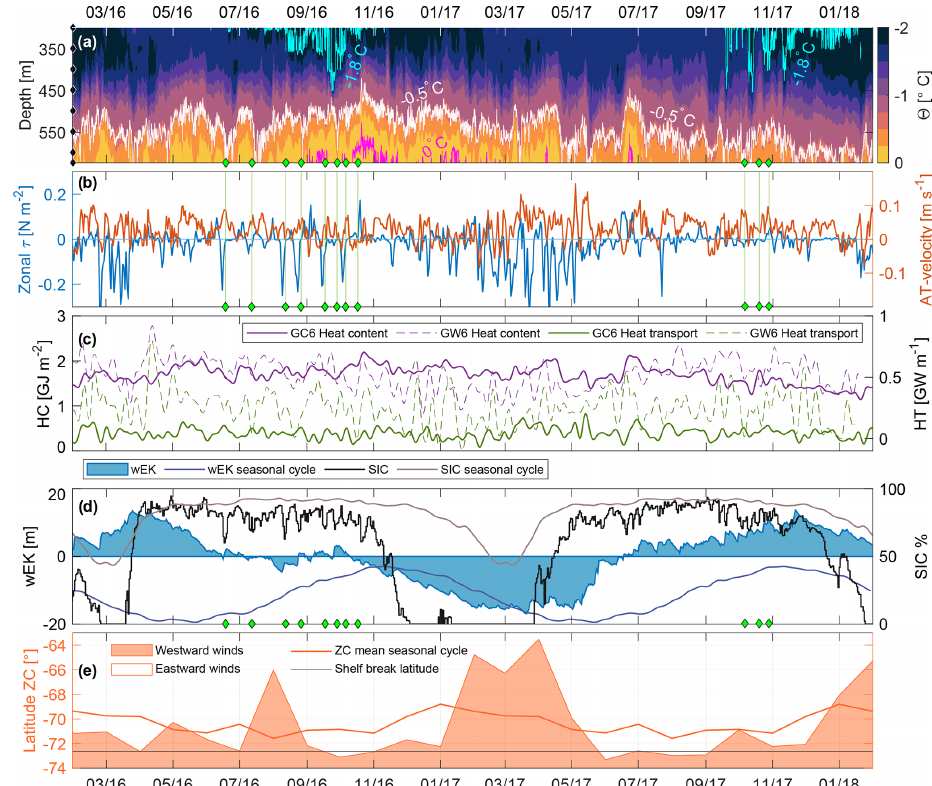
Figure 4. Daily mean records from GC 6 showing (a) conservative temperature, and (b) depth-averaged along-trough (AT) velocity at GC 6 (red) and zonal τ D18 averaged over the SB box (blue). Positive values denote flow toward the ice shelf and eastward stress respectively. The − 1 . 8 ◦ C (cyan), − 0 . 5 ◦ C (white), and 0 ◦ C (magenta) contours are highlighted in (a) , and the measurement depths are shown (black diamonds) in (a) . (c) Heat content (HC) at GC 6 (purple) and GW 6 (dashed purple), and heat transport (HT) at GC 6 (green) and GW 6 (dashed green), all LP 8D . (d) Cumulative Ekman pumping anomaly in the SB box (filled blue) and SIC over GC 6 (black), with their mean seasonal cycles (2001–2018) in dark blue and gray respectively. (e) Estimated monthly mean location of the zero-contour in a meridional band spanning the zonal extent of the SB box. The filled orange area indicates westward winds and white indicates eastward winds. The thin orange and gray lines indicate the mean monthly position of the zero-contour from 2001 to 2018, and the latitude of the shelf-break north of GC 6 respectively. Time is given as mm/yy. The green diamonds (a, b, d) and lines (d) mark the strong cooling events observed at GW 6F (Steiger et al.,